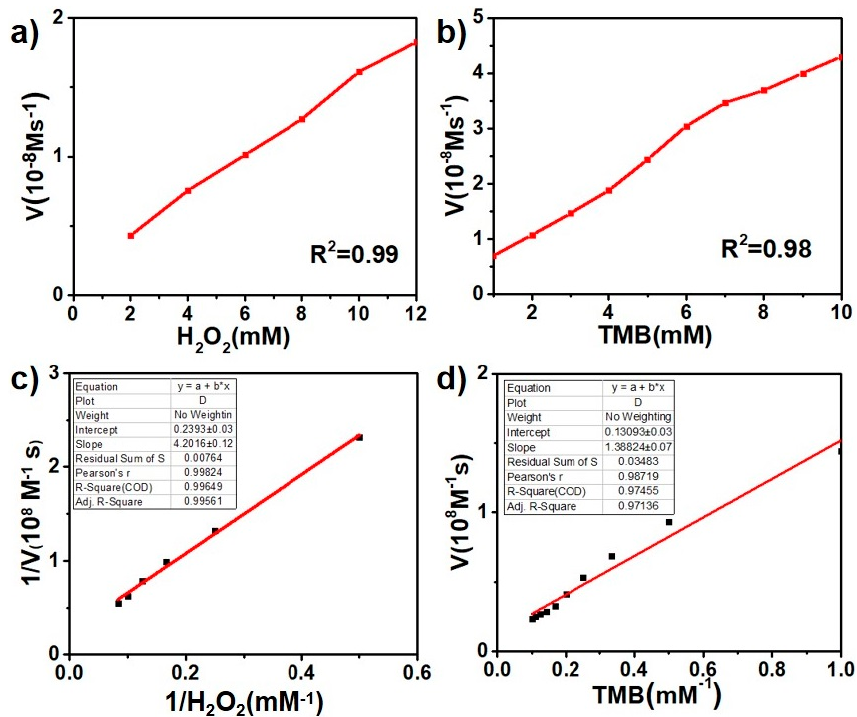
Figure 7. Steady-state kinetic assay and catalytic mechanism of the Pd 1 Cu 7 alloy NPs. ( a ) The con- centration of TMB was 20 mM and varied concentration of H 2 O 2 . ( b ) The concentration of H 2 O 2 was 100 mM and varied concentration of TMB. ( c , d ) Double-reciprocal plots of activity of the Pd 1 Cu 7 alloy NPs at a fixed concentration of one substrate versus varying concentration of the second sub- strate.